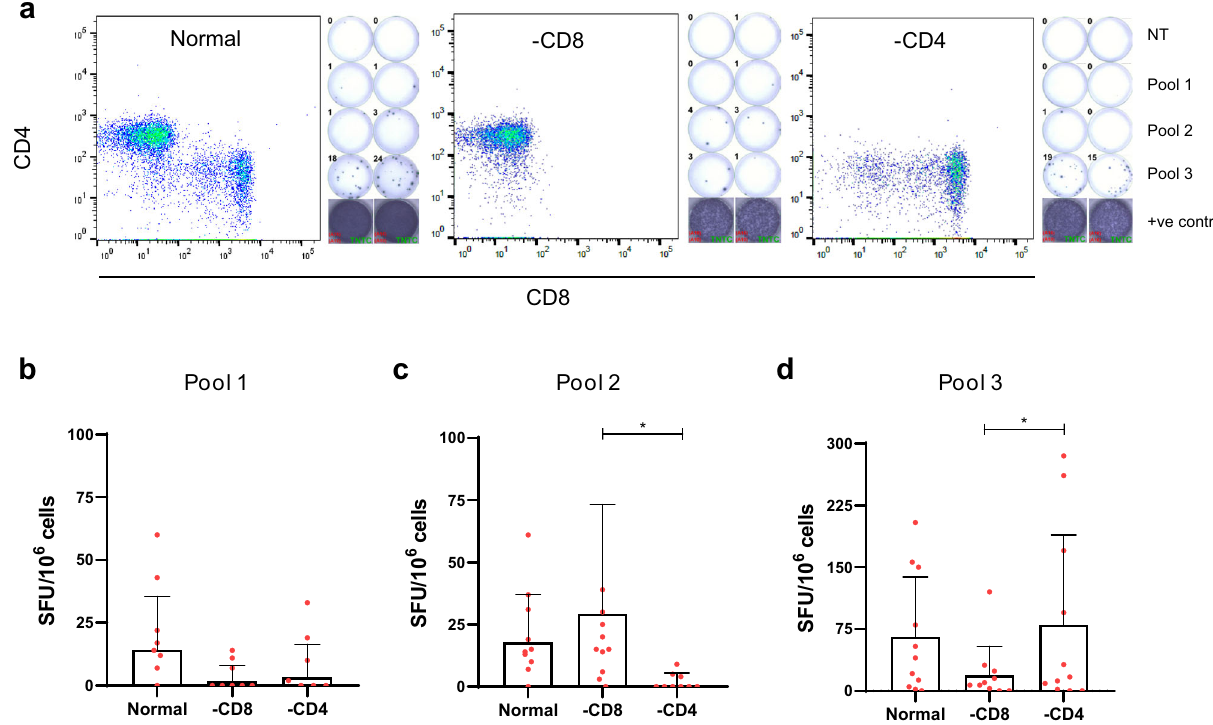
Fig. 3 EVD survivor T cell memory response to EBOV glycoprotein GP1-4. IFN γ ELISpot using EVD survivor PBMC that were depleted of either CD4 + ( − CD4) or CD8 + ( − CD8) T cells. a Representative fl ow cytometry and ELISpot images for survivor C052 showing that PBMC were successfully depleted for the desired T cell population and the corresponding ELISpot response to the various stimulation conditions. b – d Response to GP1-4 peptide sub-pools. ( b ) shows the response to sub-pool 1 which consists of peptides 69 – 73, ( c ) shows the response to sub-pool 2 which contains peptides 74 – 80 and ( d ) shows the response to sub-pool 3 which contains peptides 81 – 88. Data show the mean + SD of 11 EVD survivor samples. One-way ANOVA with repeated measures used for statistical analysis in ( c ) p = 0.0264 and in ( d ) p = 0.0255, n = 11 biological independent samples examined over 2 independent